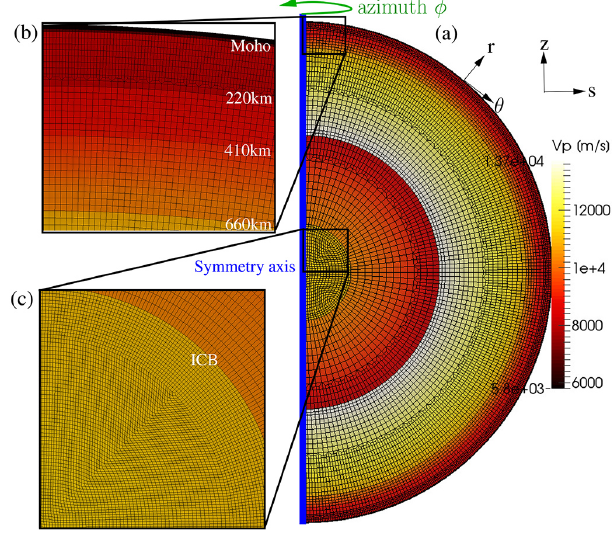
Figure 3. The 2-D computational domain D upon which the col- lapsed numerical system operates with a symmetry axis (blue). The method solves the three-dimensional equations of motion, but al- lows for an analytical representation within the azimuthal dimen- sion (green). Sources and structure therefore obey axisymmetry with respect to the axis. Colors denote compressional velocities of the PREM model (Dziewonski and Anderson, 1981), and black lines an elemental mesh for a seismic period of 20s. Zoom panels show a higher-resolution version (5s) with upper-mantle disconti- nuities honored by the mesh (b) , as well as the rotated-coordinate meshing below the inner-core boundary (ICB) (Nissen-Meyer et al.,